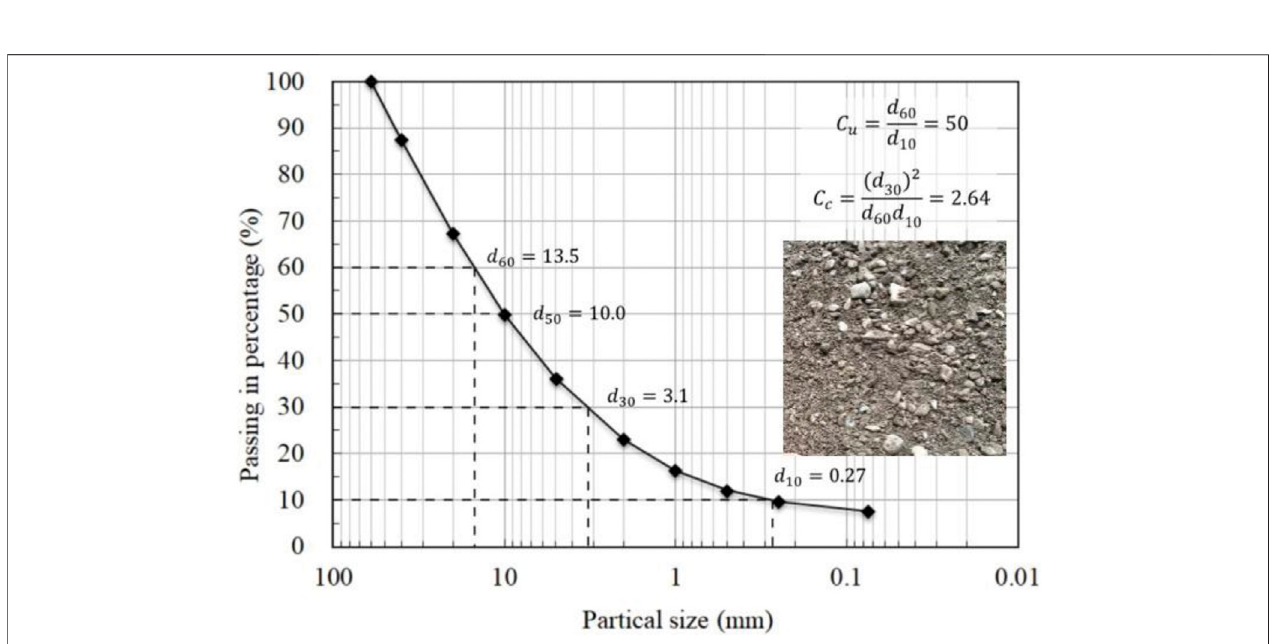
FIGURE 2 | The particle size distribution of dam materials.